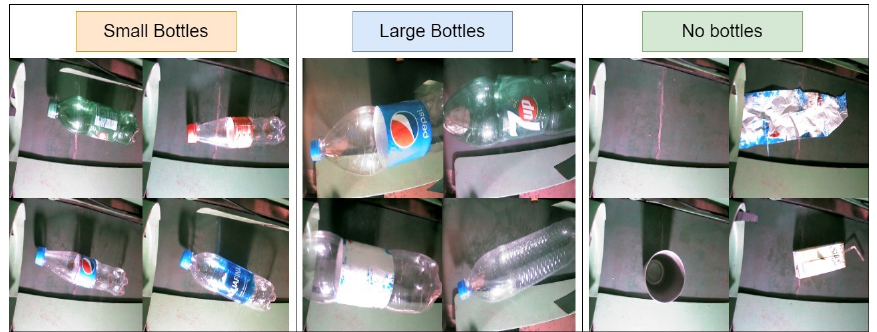
Figure 6. Data collected from inside of the